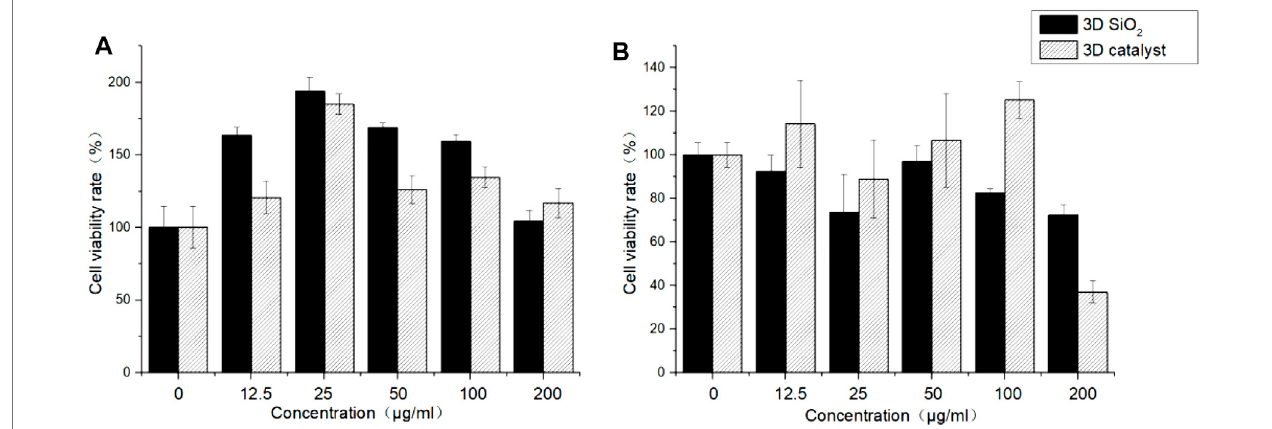
FIGURE 6 | Cytotoxicity test of the materials (A) : 24 h; (B) : 48 h.